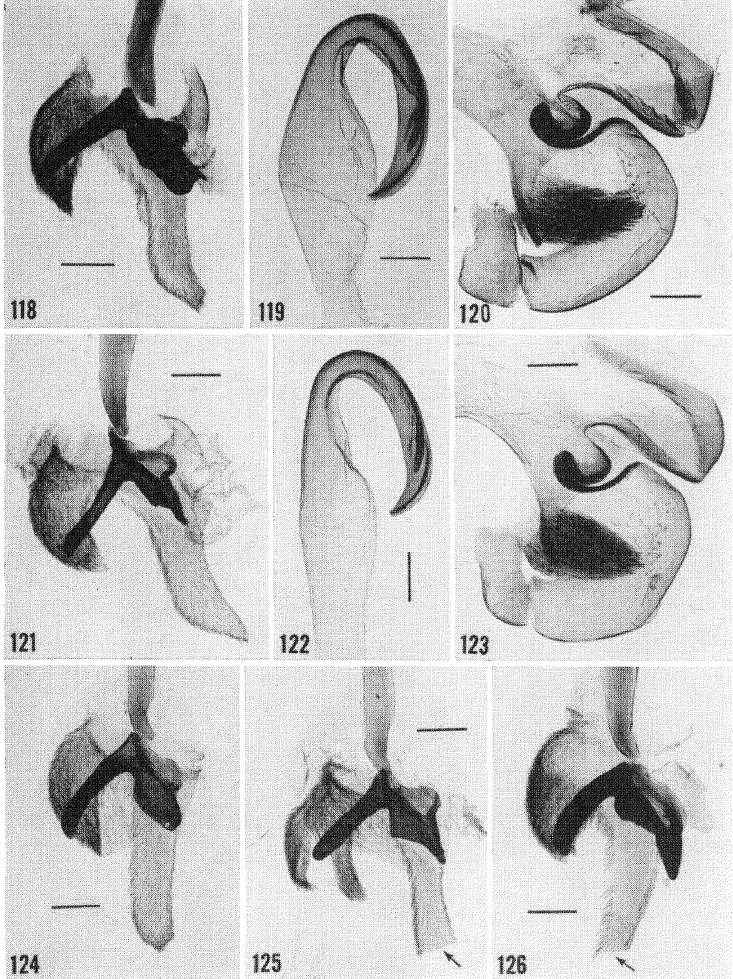
Figs. 118-126. Cockroach male genitalia. Eplampra .uianae. 118-120. (35 ANSP). Paratype. Roekstone, British Guiana. 121-123. (91 USNM). Surinam. 124. (90 USNM). 125. (89 USNM). Brokopondo, Surinam. 126. (92 USNM). Surinam. (tips of prepuce (arrows) in figures 125 and 126 missing). (121-126, det. Roth). (scale 0.2